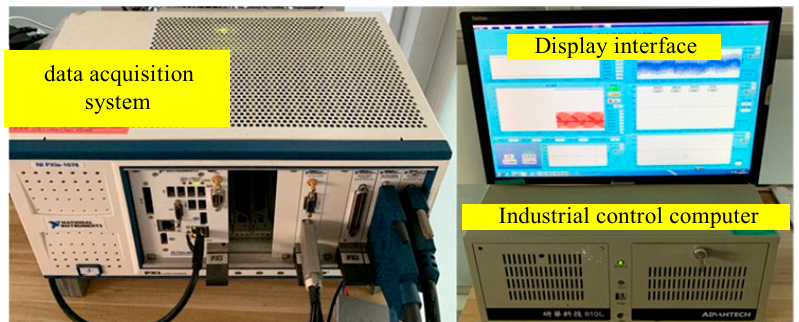
Figure 9. Experimental data collection system.